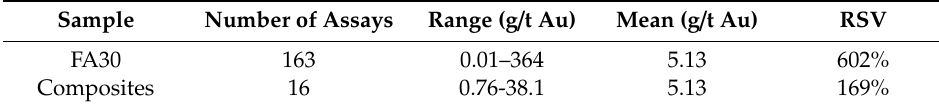
Table 7. Fire assay extinction test results for NQ2 core pulp.